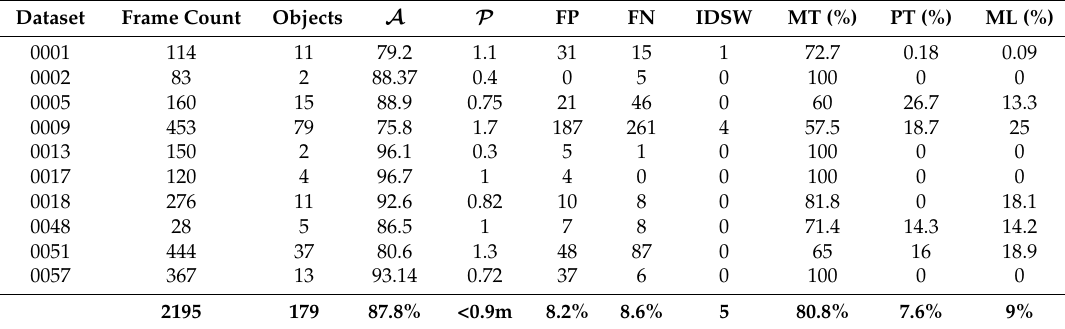
Table 1. Datasets information with tracking evaluation